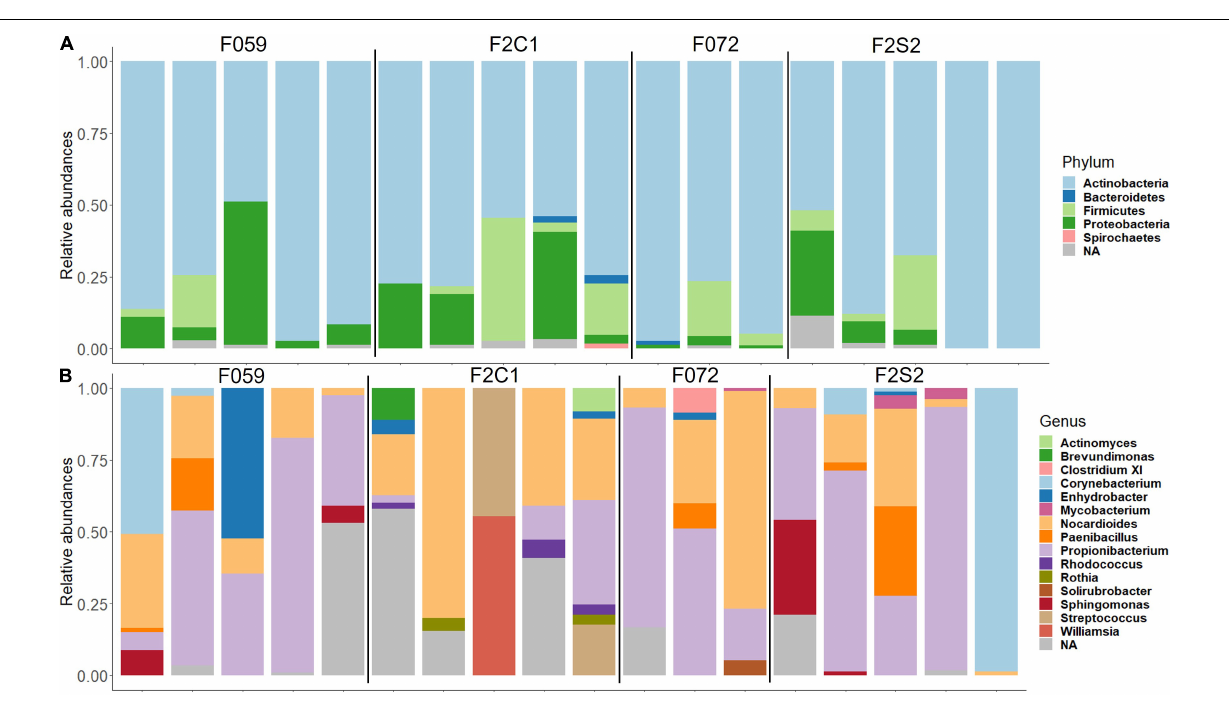
one ASV belonging to Nocardioides ( DENOVO 2) was not found in F2S1